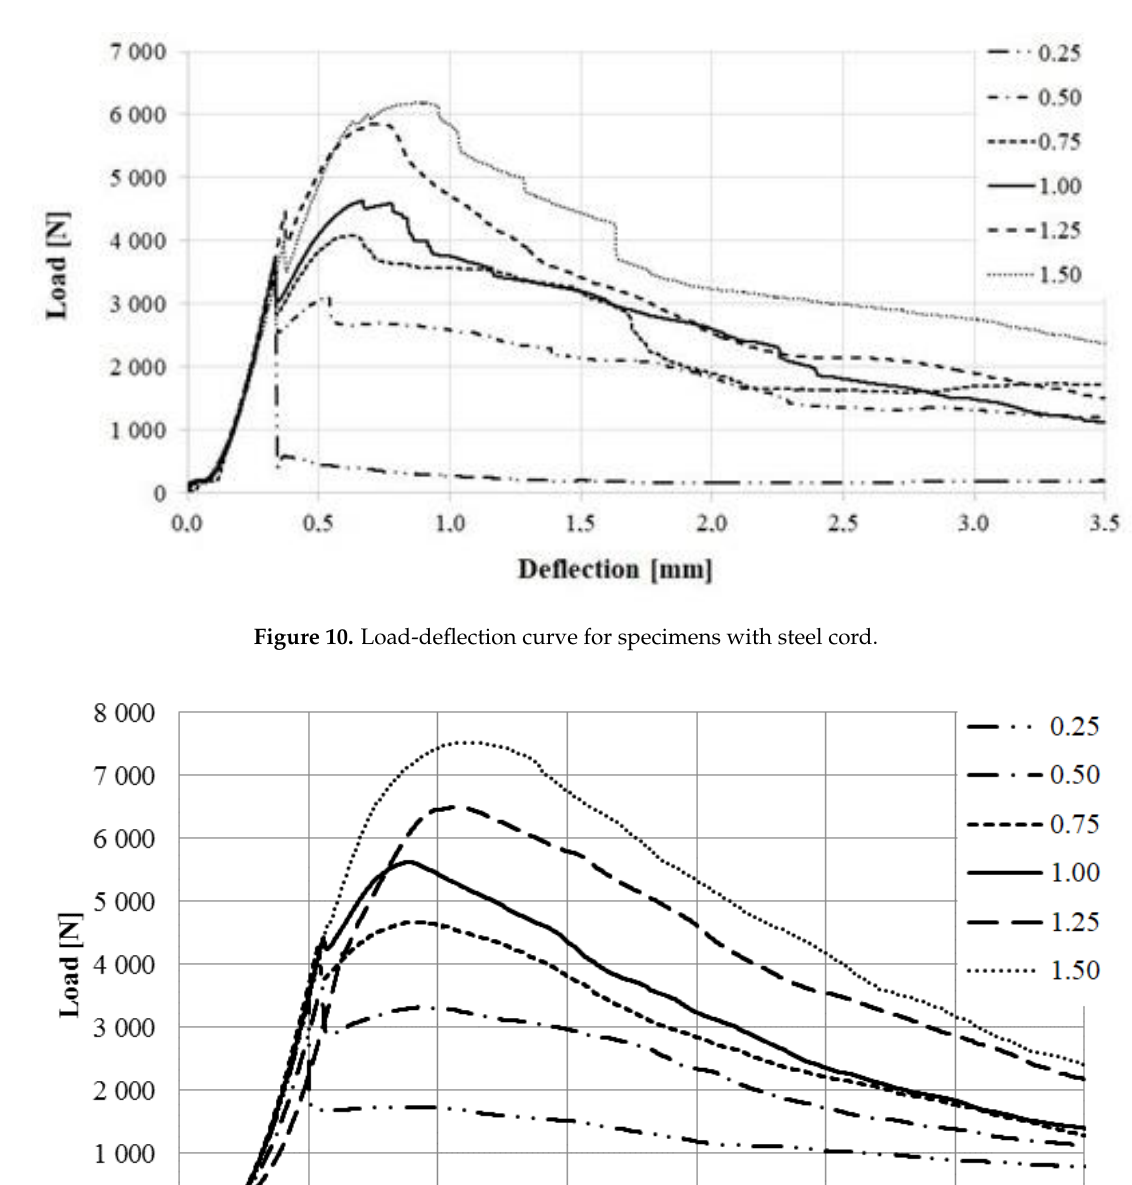
Figure 9. Flexural strength.